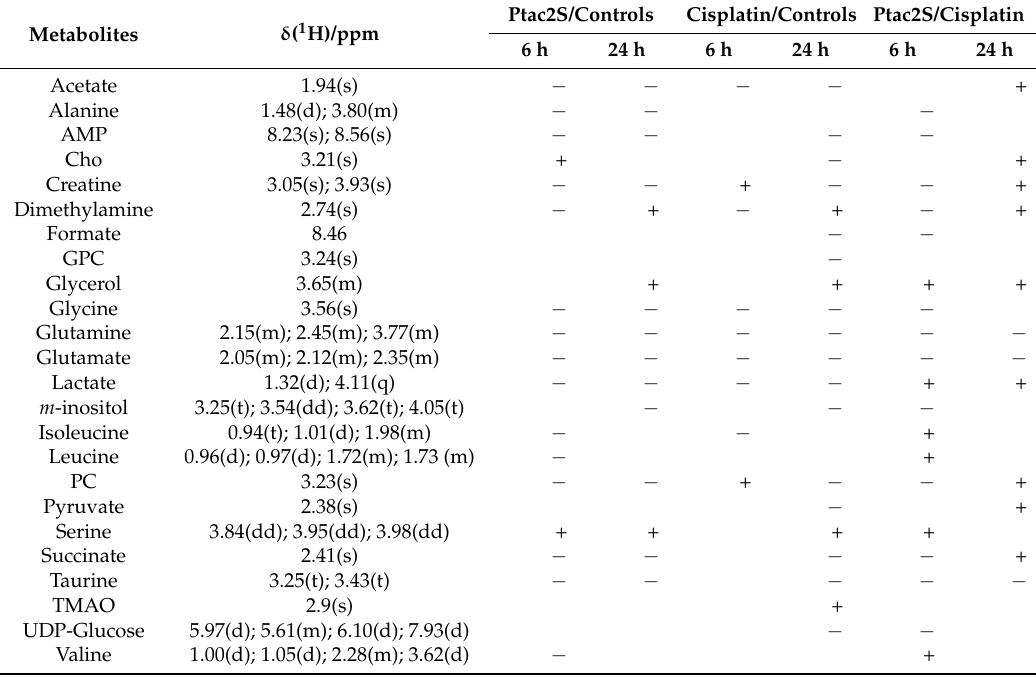
Table 1. Relevant metabolites derived from the pairwise OPLS-DA models of 1 H-NMR analysis of aqueous extracts between controls and Ptac2S and cisplatin treated samples. Positive (+) and negative ( − ) sign indicate positive and negative correlation in the concentration,